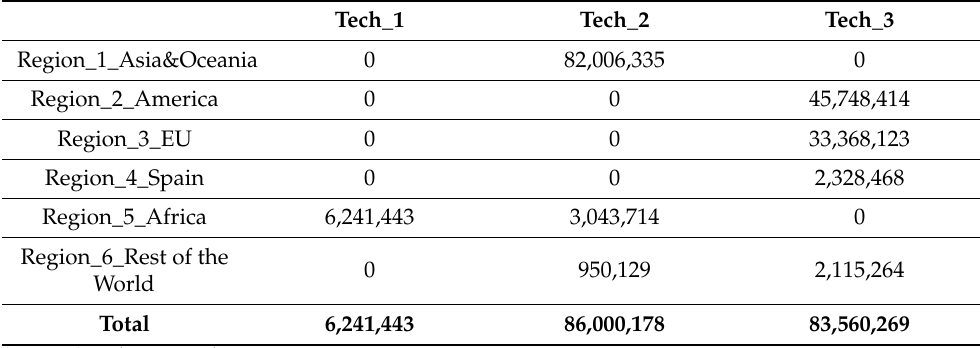
Table 14. f2 + no factor constraints. Solution of x by region and technology (million